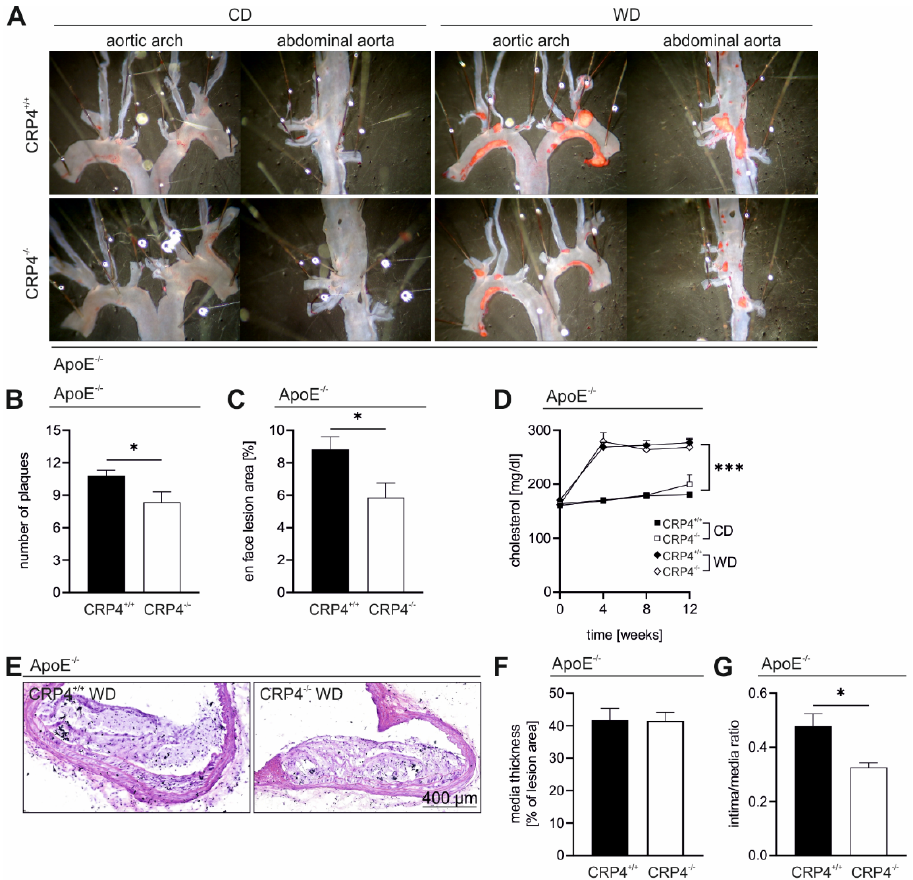
Figure 2. Absence of CRP4 attenuated atherosclerotic plaque progression in the aorta of WD-fed ApoE − / − . ( A ) En face Oil Red O staining of the aortic arch and the abdominal aorta of 16-week CD- vs. WD-fed ApoE − / − /CRP4 +/+ and dKO mice. ( B , C ) Quantification of the plaque burden and size of the Oil Red O-stained areas within the plaques revealed a significantly decreased number of plaques and Oil Red O-stained atherosclerotic lesion area in ApoE − / − /CRP4 − / − mice compared to their littermate controls; n = 12–14 per genotype, * p < 0.05 and two-tailed Student’s t -test. ( D ) Cholesterol blood level of ApoE − / − mice after 0, 4, 8 and 12 weeks were significantly elevated under WD versus CD condi- tions; n = 4–10 per group, *** p < 0.001 and two-tailed Student’s t -test. ( E , F ) Representative H&E- stained cross-sectional images prepared from atherosclerotic lesion area did not reveal differences in media thickness in the plaque region. ( G ) Consistent with the Oil Red O staining, the intima/me- dia ratio in H&E-stained aorta cryosections of dKO aorta was significantly reduced; n = 6–7 per genotype, * p < 0.05 and two-tailed Student’s t -test. All data are expressed as the mean ± SEM.